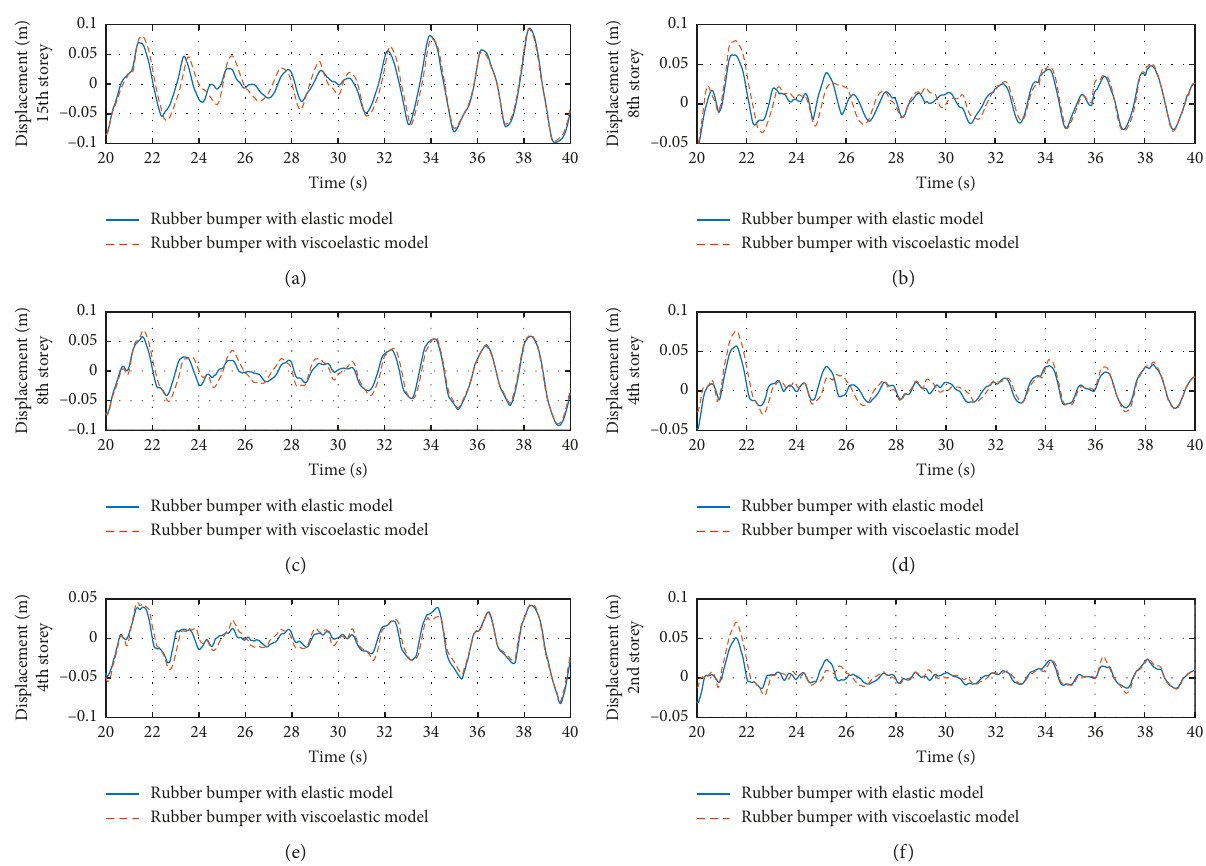
Figure 7: Comparison of displacement results between elastic and viscoelastic models with different dash-pot damping parameters for (a) left building storeys and (b) right building